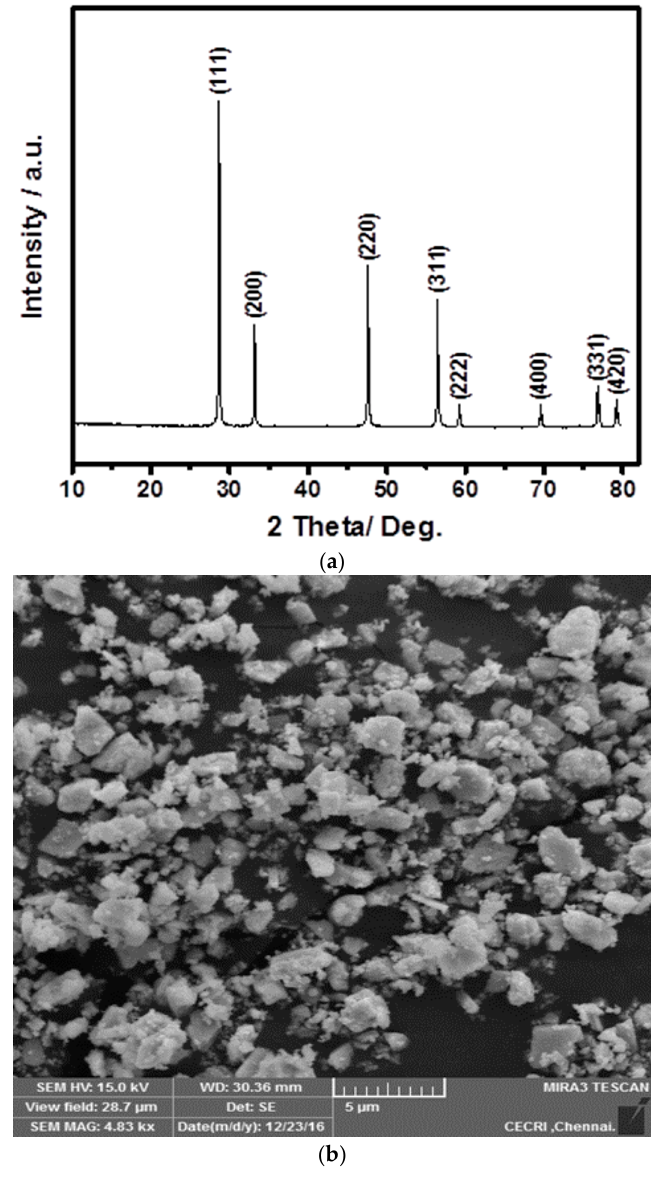
Figure 1. X-ray diffraction pattern ( a ) and FE-SEM image ( b ) of CeO 2 nanoparticles.